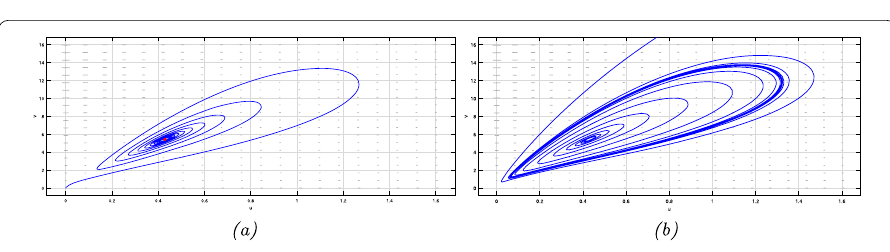
Figure 3 Phase portrait of system (2.1) with parameters in (4.3): ( a ) the equilibrium is asymptotically stable where d = 0.5 > d 0 ; ( b )the equilibriumis unstable and the periodic solution is stable where d = 0.45 < d